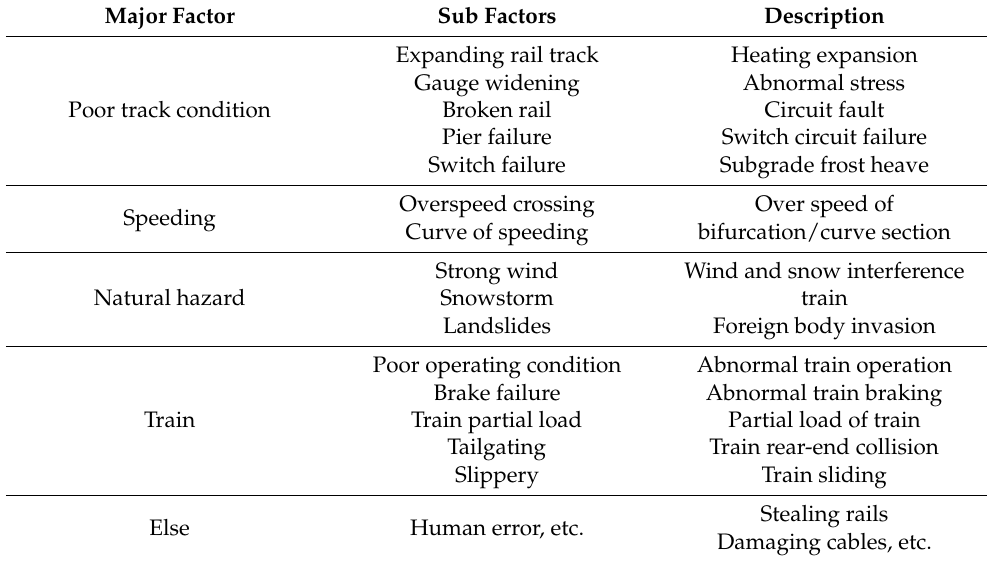
Table 1. Factors of train derailment